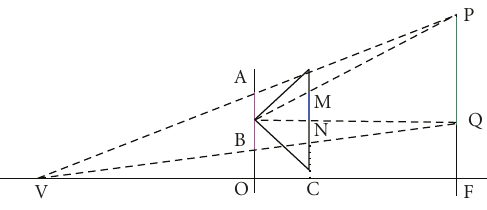
Figure 7: Geometry in region selection of